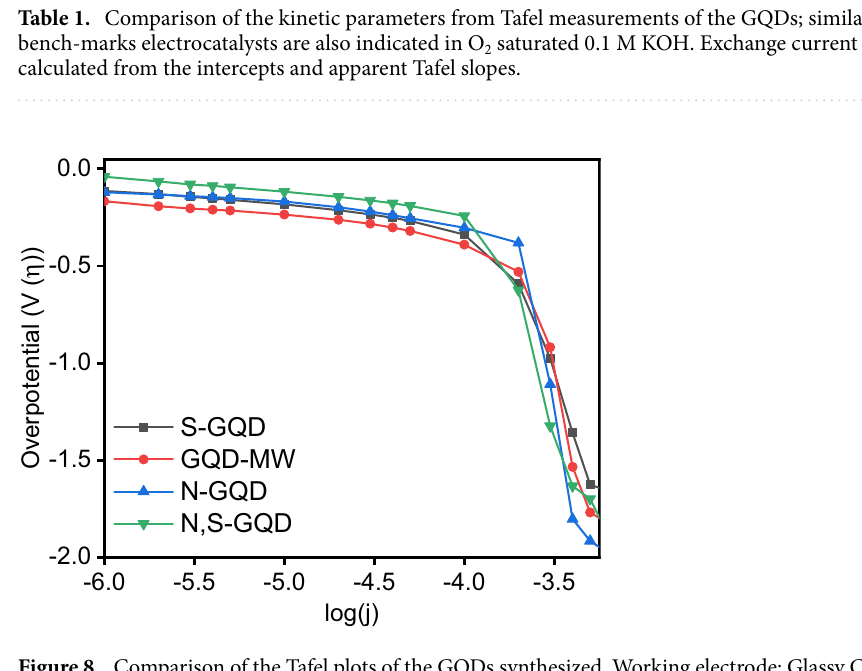
Figure 8. Comparison of the Tafel plots of the GQDs synthesized. Working electrode: Glassy Carbon, Counter Electrode: Pt Coil, Reference electrode: Hg/HgO. Steady-state measurements were taken in a galvanostatic manner, constant current was passed through the electrode until a steady state was